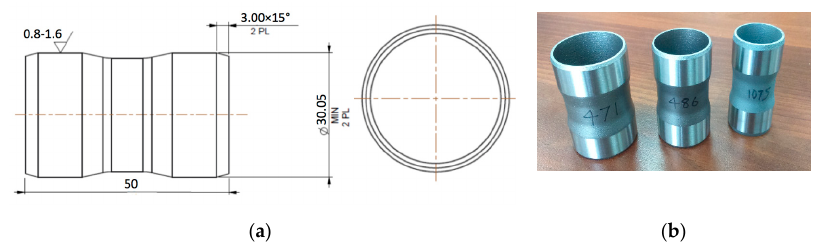
Figure 1. Details produced by AM technology for tests: ( a ) scheme; ( b ) photograph.